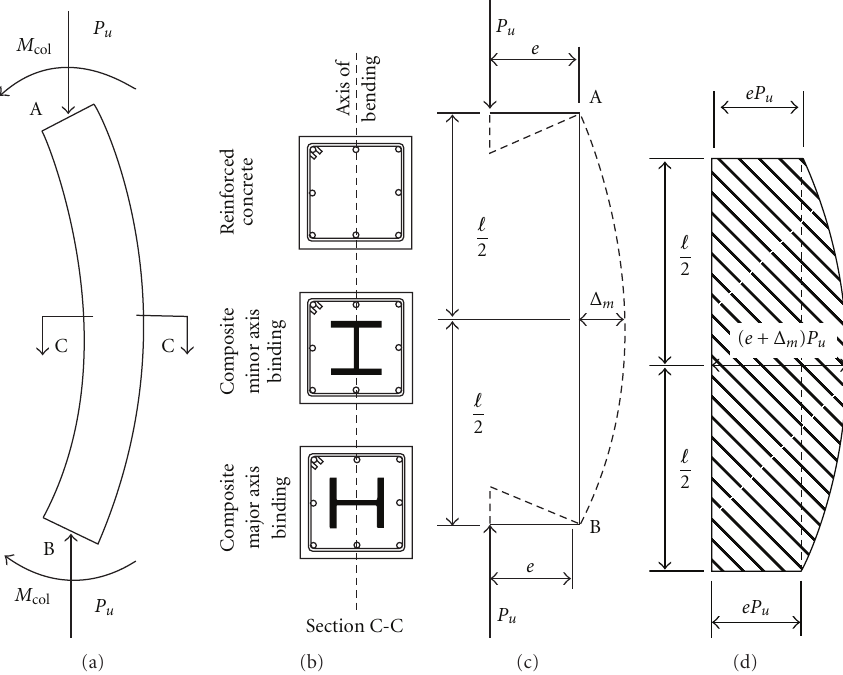
Figure 1: Type of columns studied: (a) free-body diagram of pin-ended column in symmetrical single-curvature bending, (b) schematic cross-sections, (c) forces on column, and (d) bending moment diagram ( M col = eP u ; M cs = ( e + Δ m ) P u ).